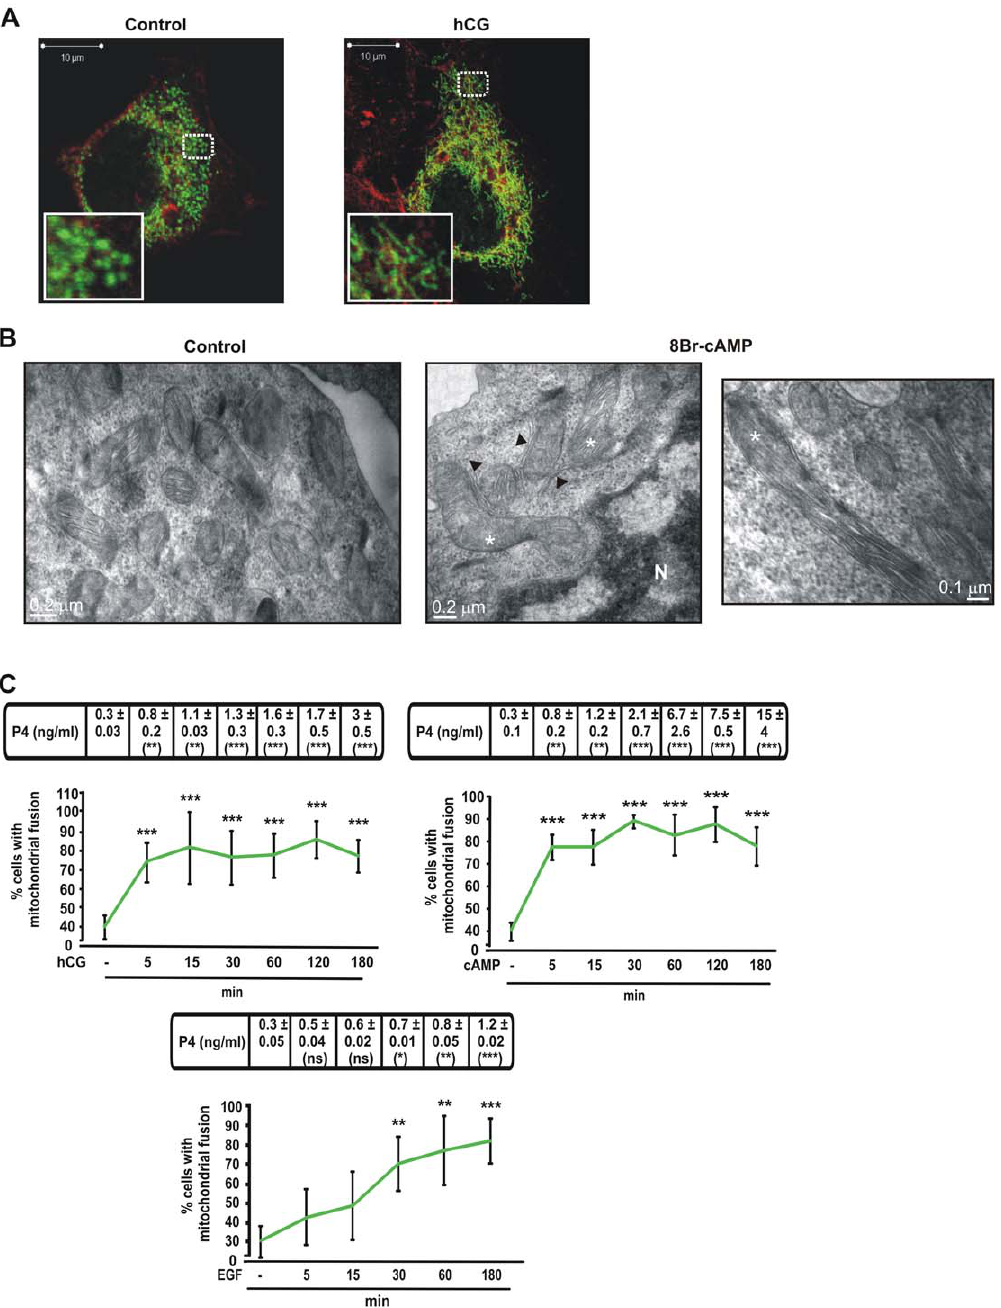
Figure 1. Hormonal stimulation causes an increase in fused mitochondria morphology in MA-10 cells. A. Representative confocal images of the MA-10 cell line transfected with mtYFP (mito, Green). After 24 h transfection, cells were stimulated with or without hCG (20 ng/ml) for 1 h. Cell morphology was visualized by actin red staining with the fluorescence dye Phalloidin–TRITC (1:2000), incubated for 1 h at room temperature. Scale bar, 10 m m. B. Representative Electron micrographs of mitochondria in MA-10 cells. Cells were stimulated with or without 8Br- cAMP (1 mM) for 1 h. Scale bars, 0.2 m m. Higher magnification of another section is shown for 8Br-cAMP-treated cells (left panel). Scale bar; 0.1 m m. Asterisks indicate tubular, elongated mitochondria. Arrowheads indicate ER. C. After 24 h transfection with mt-YFP, MA-10 cells were treated with or without hCG (20 ng/ml), 8Br-cAMP (1 mM) or EGF (10 ng/ml), for the indicated times. Cells were processed as described in materials and methods and observed with a fluorescence microscope. Cells with the indicated mitochondrial morphology shown in right image of panel A, named as mitochondrial fusion in the graphics, were quantified. More than a hundred cells were counted manually in at least four distinct optical fields. Quantitative analysis of fused mitochondria is shown. Results are expressed as the means 6 SEM of three independent experiments. *** P , 0.001 vs. control. ** P , 0.01 vs. control. Cellular medium was used to determine P4 production by RIA. Results of P4 measurement are indicated at the top of each graph as the means 6 SEM of three independent experiments. ns P . 0.05 vs. control. *** P , 0.001 vs. control. ** P , 0.01 vs. control.